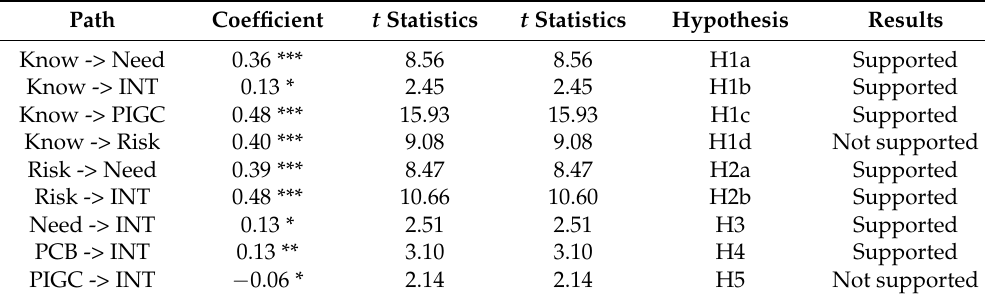
Table 4. Path coefficients of the structural